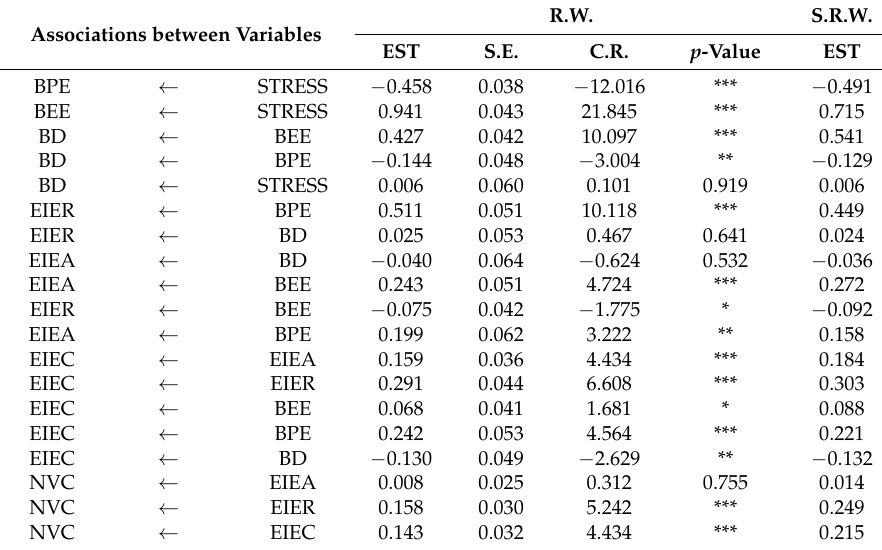
Table 2. Regression weights and standardized regression weights. Associations between Variables